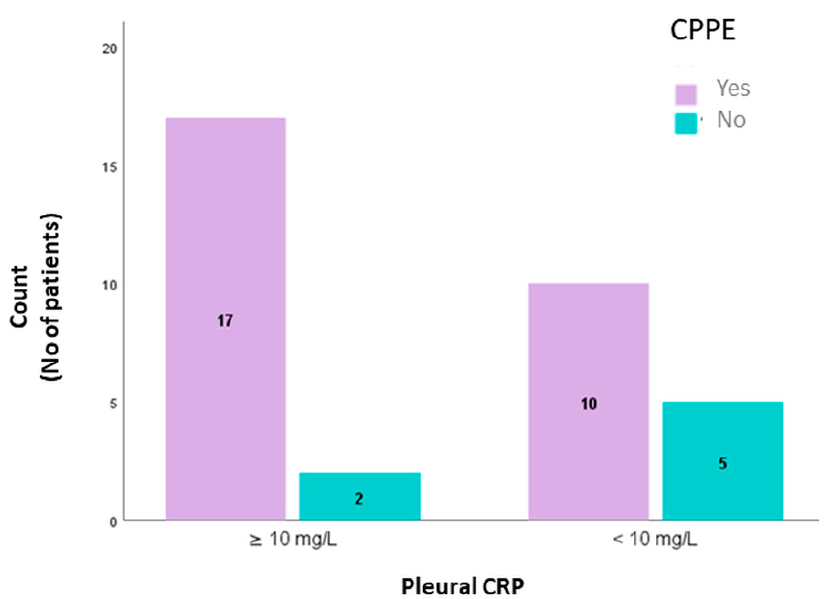
Figure 3. Distribution of patients in CPPE and non- CPPE groups based on a cut-off of pleural CRP ≥ 10mg/dl. CRP: C-reactive protein, CPPE: complicated parapneumonic pleural effusion.